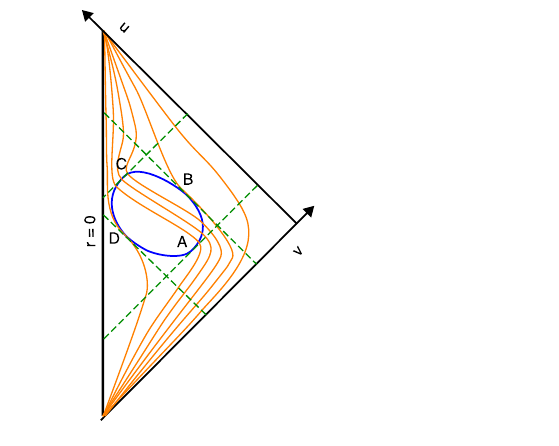
Figure 3 . The schematic Penrose diagram with an anti-trapping horizon. The interpretation of this diagram is analogous to (cid:12)gure